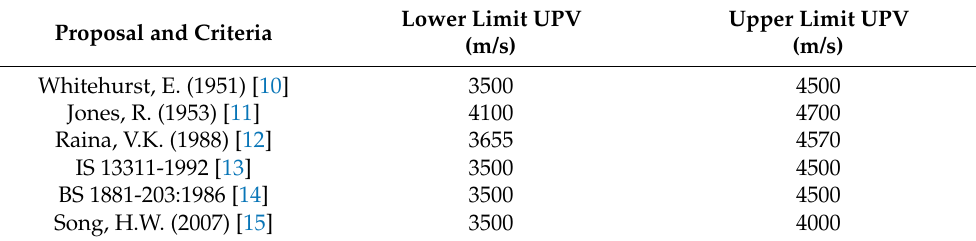
Table 3. Reference of typical concrete quality “good” using the ultrasonic velocity range. Proposal and